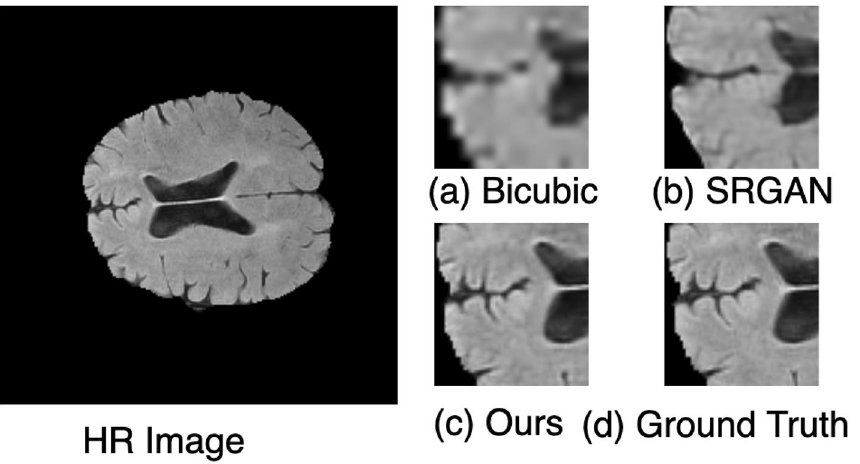
Figure 12. Small region results on MRI image. The sub-region for ( a ) Bicubic interpolation. ( b ) SRGAN 31 . ( c ) Proposed architecture. ( d ) Ground truth HR image.